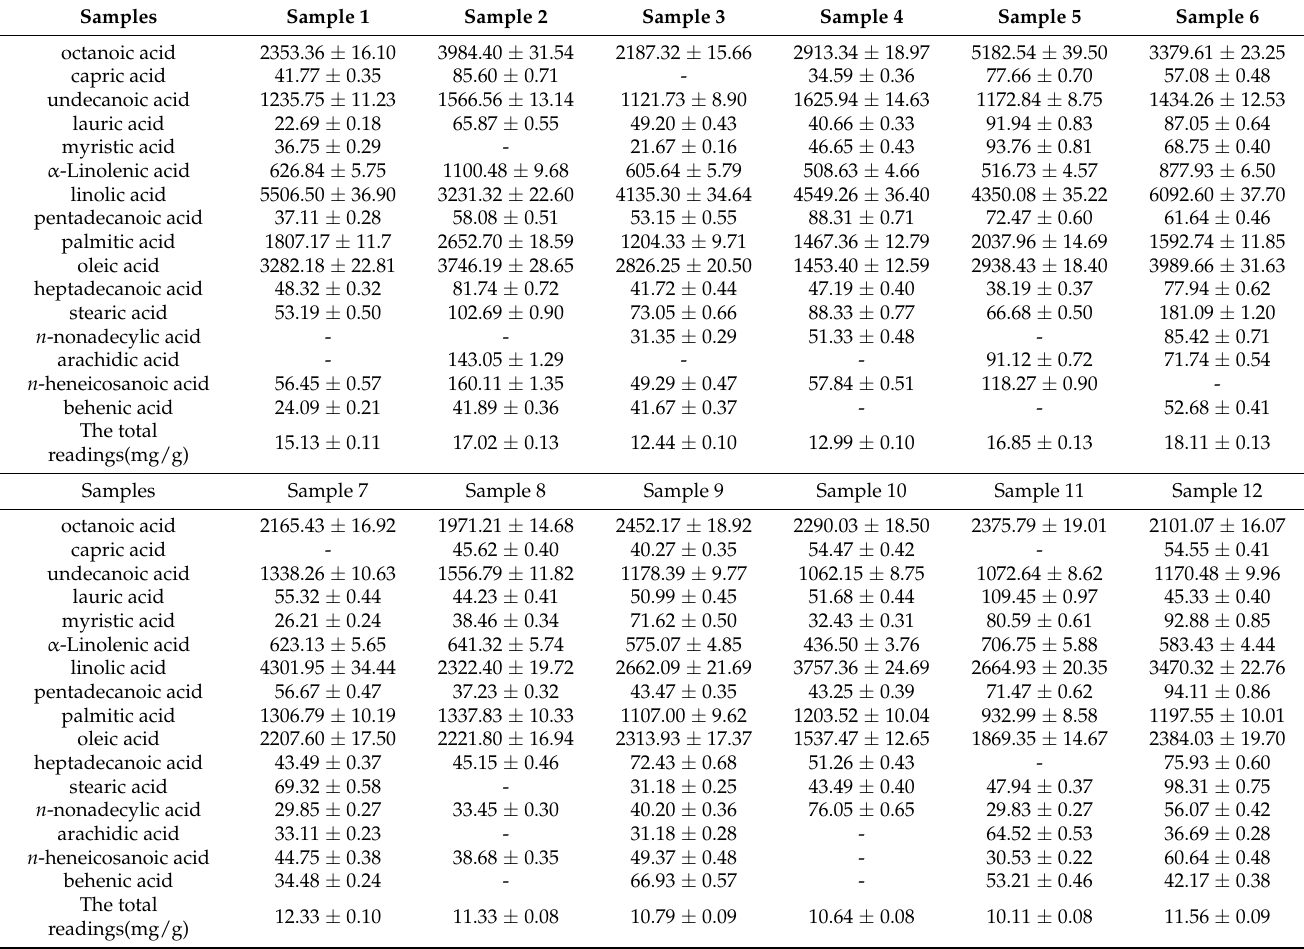
Table 8. The contents of fatty acids from Potentilla anserina L. by UAE ( µ g/g, n = 3).